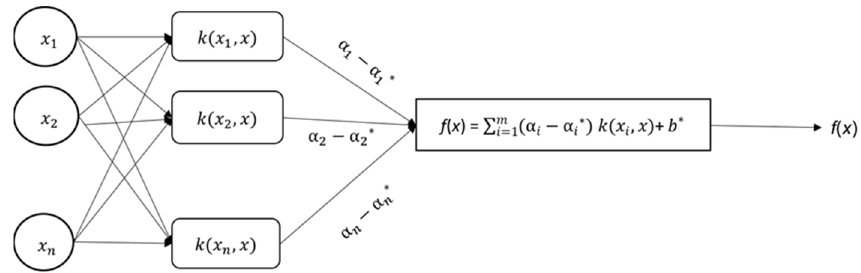
Figure 1. SVR regression model structure diagram.